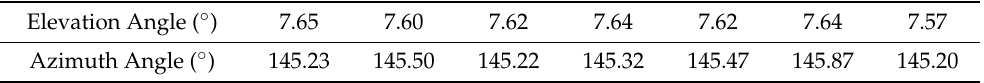
Table 15. DOA estimation by UCMA-ESPRIT for outer race fault signal at 725 rpm.